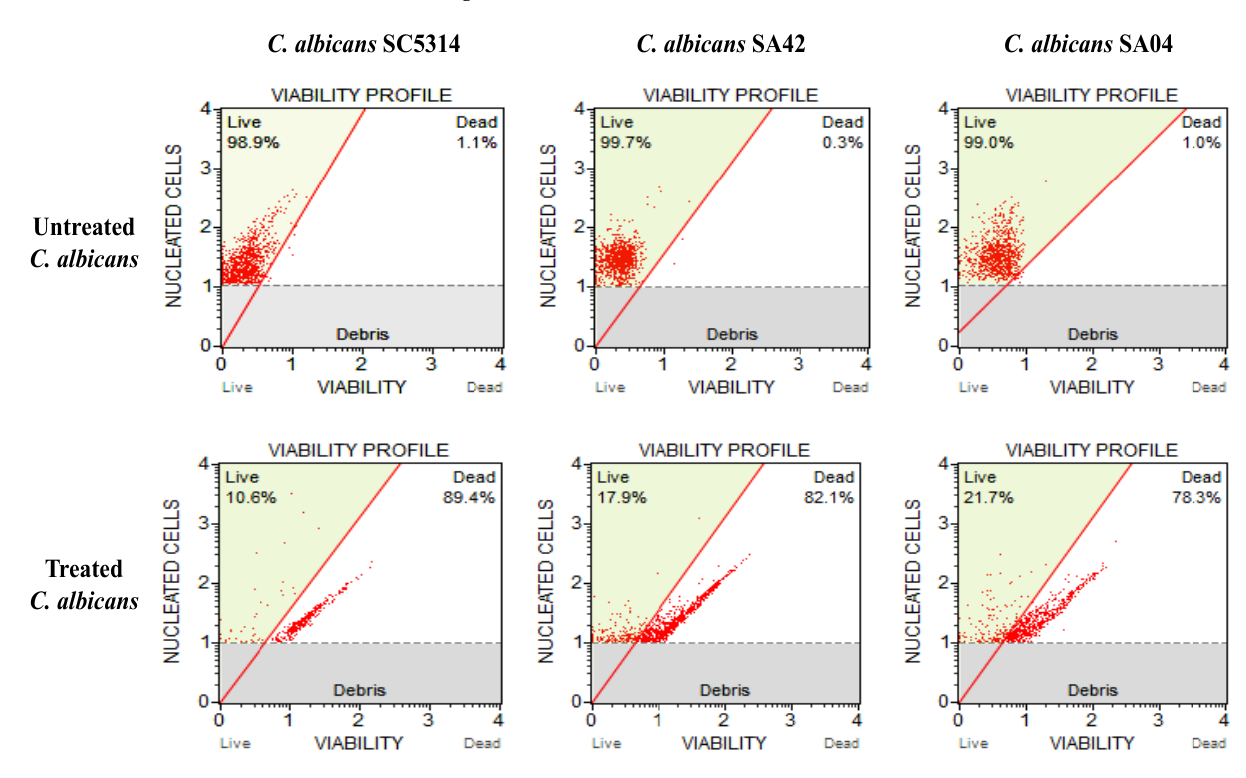
Figure 2. Effect of HNP on C. albicans cell viability. The figure shows C. albicans viability profile. Untreated control: unexposed C. albicans cells; C. albicans exposed to varied MIC values of the test compound.